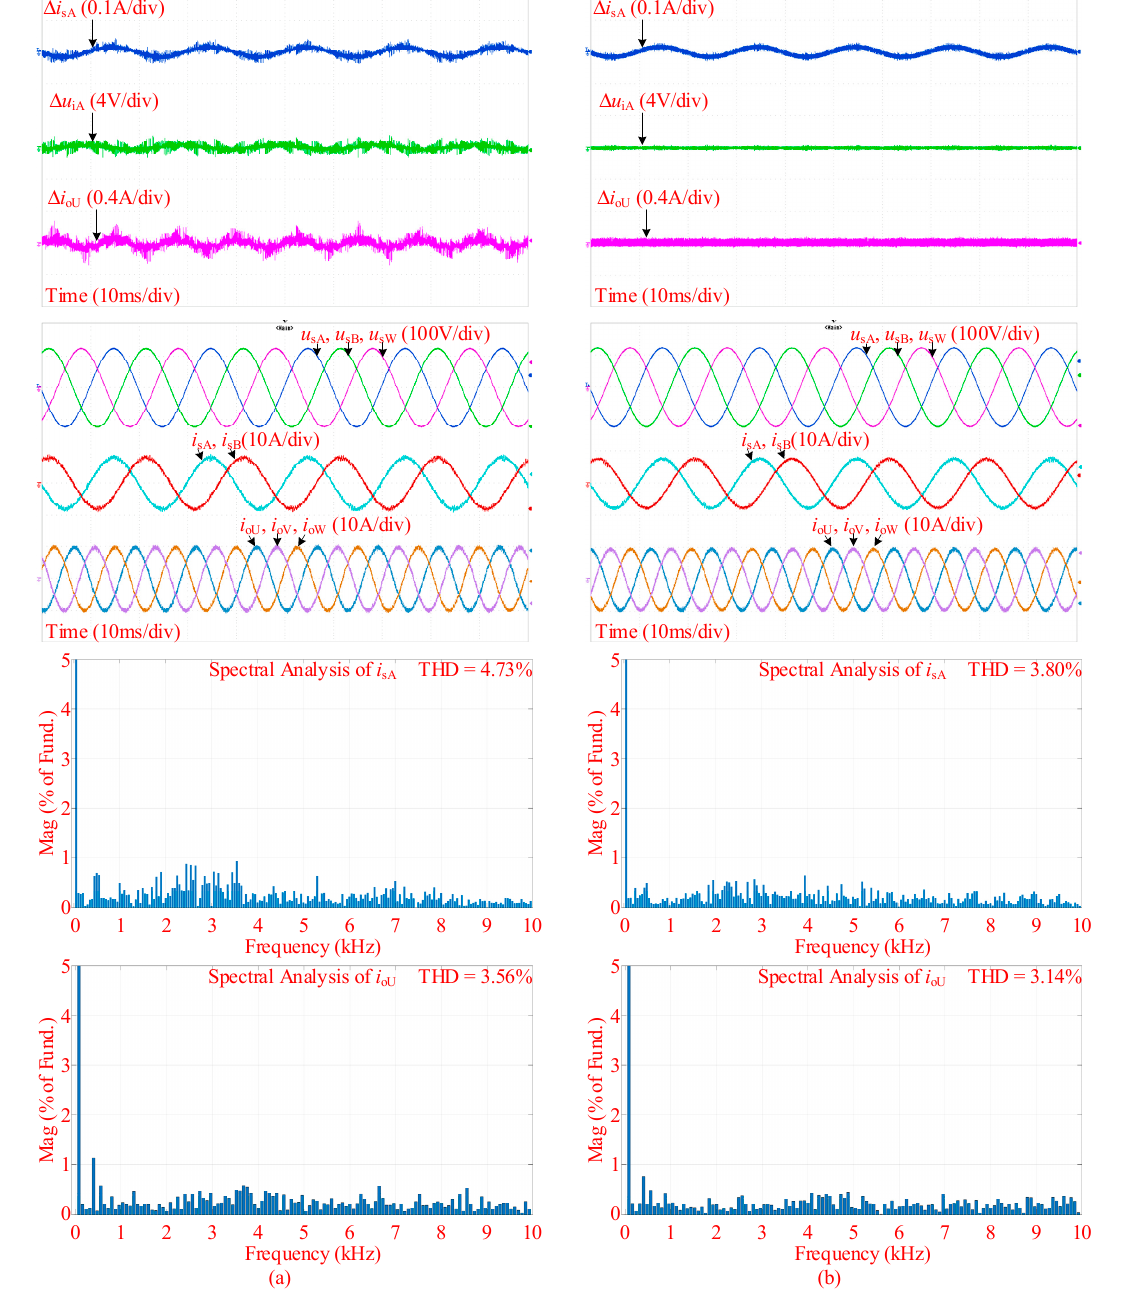
Figure 9. Experimental results of Case 4: ( a ) with the conventional MPC and ( b ) with the improved MPC. Output filter inductor is changed to 2.51 mH.